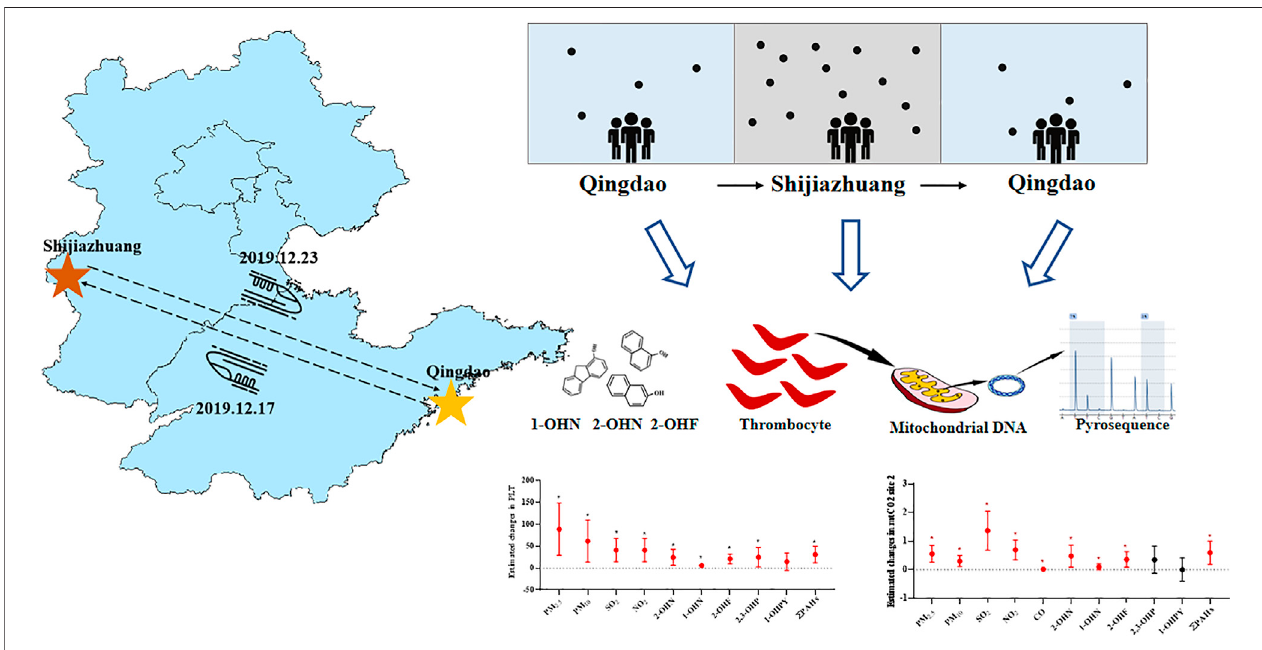
FIGURE 7 | Flow chart of the panel